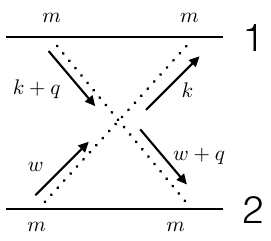
Figure 2 . The two loop diagram with the \cross" topology. Arrows indicate the direction of the momentum (cid:13)ow. The m ’s in the vertex speci(cid:12)es that we used the leading source-gravity